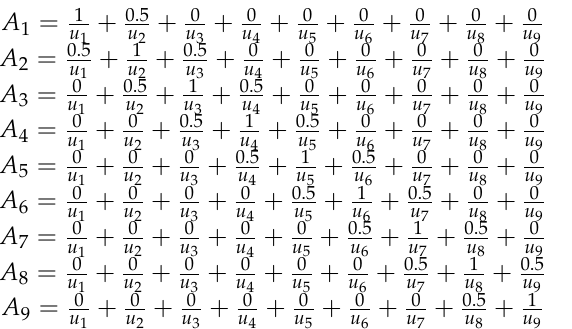
Table 21. The coupon rate linguistic variable. A 1 The lowest coupon rate A 2 Lower coupon rate A 3 low coupon rate A 4 Below average coupon rate A 5 Average coupon rate A 6 Upper coupon rate A 7 High coupon rate A 8 Higher coupon rate A 9 The highest coupon rate The membership function of the coupon rate linguistic variable is defined in